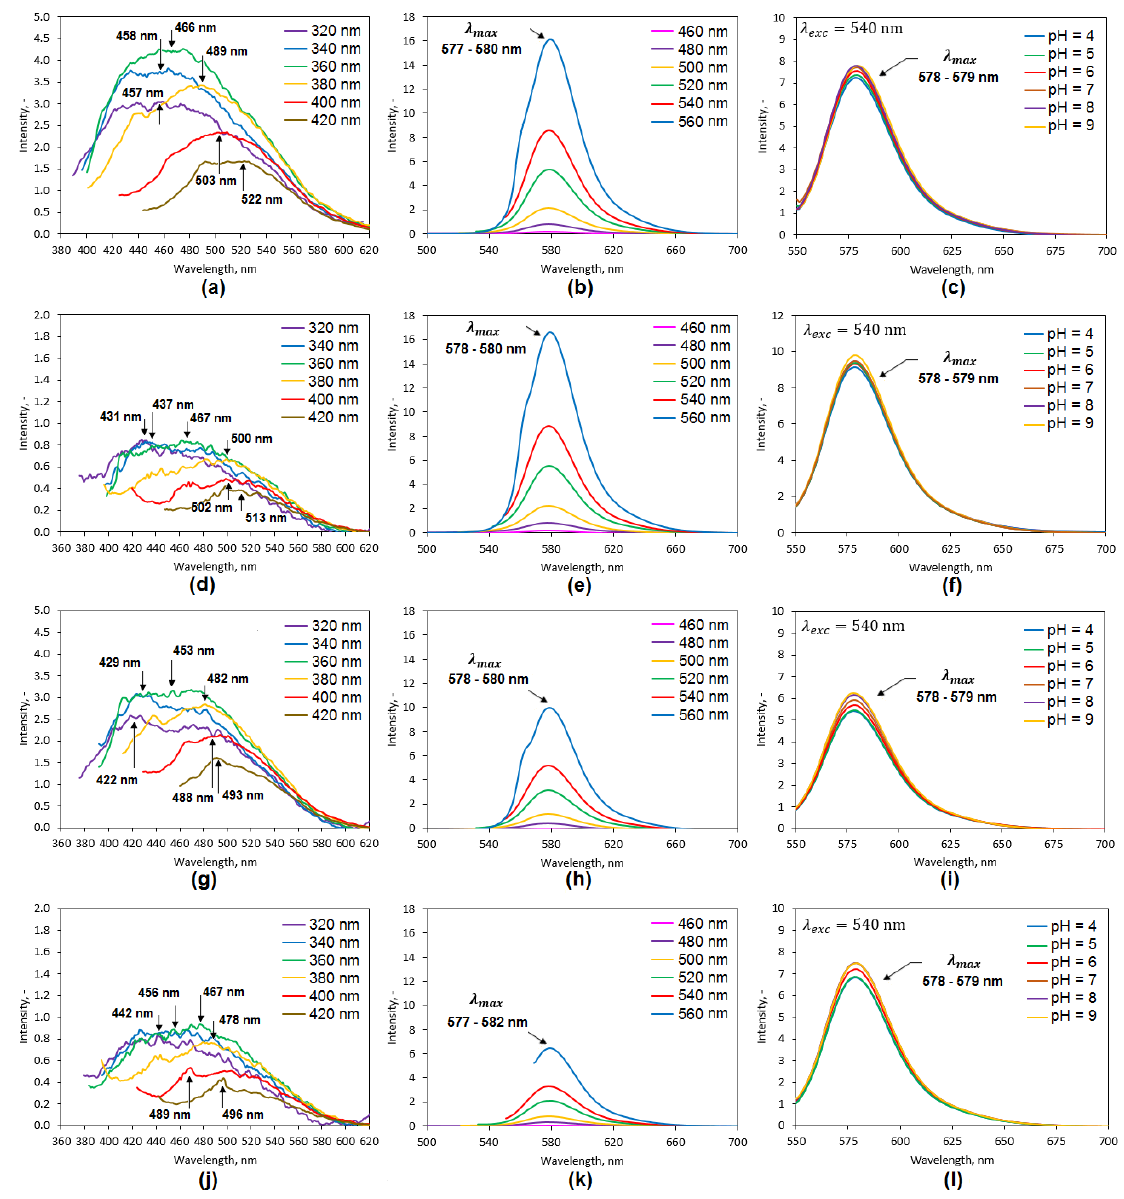
Figure 7. PL spectra of the prepared samples: ( a ) Dot-1 fluorescence spectrum; ( b ) Dot-R fluorescence spectrum; ( c ) Dot-1-R fluorescence dependence on pH; ( d ) Dot-2 fluorescence spectrum; ( e ) Dot-2-R fluorescence spectrum; ( f ) Dot-2-R fluorescence dependence on pH; ( g ) Dot-3 fluorescence spectrum; ( h ) Dot-3-R fluorescence spectrum; ( i ) Dot-3-R fluorescence dependence on pH; ( j ) Dot-4 fluorescence spectrum; ( k ) Dot-4-R fluorescence spectrum; ( l ) Dot-4-R fluorescence dependence on pH .